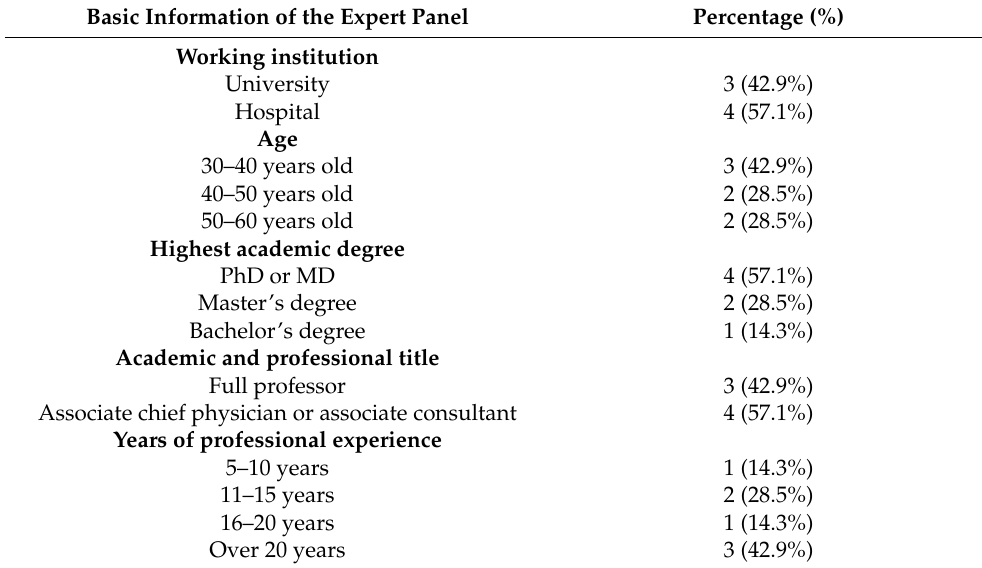
Table 2. Basic information of the expert panel (N = 7).